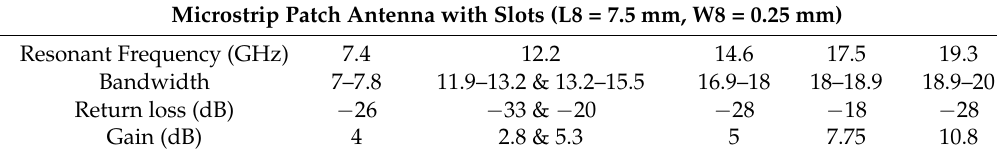
Table 2. Different parameters of the proposed antenna.